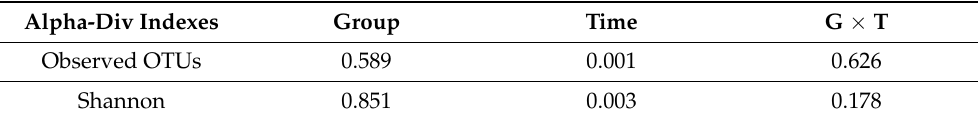
Table 3. p -values associated with the statistical analysis of the alpha diversity indexes of the bacterial and archeal communities in the ruminal samples with a linear mixed